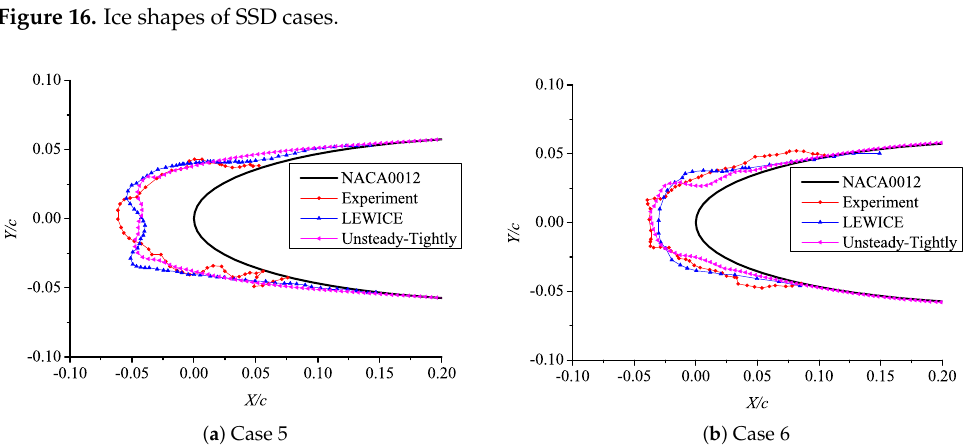
Figure 16. Ice shapes of SSD cases.